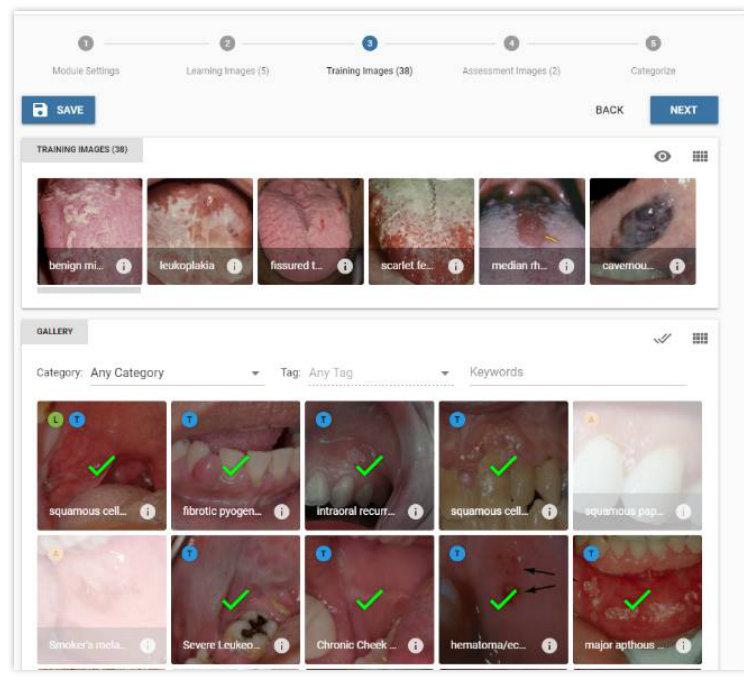
Figure 2. The selected images assigned to a stage.